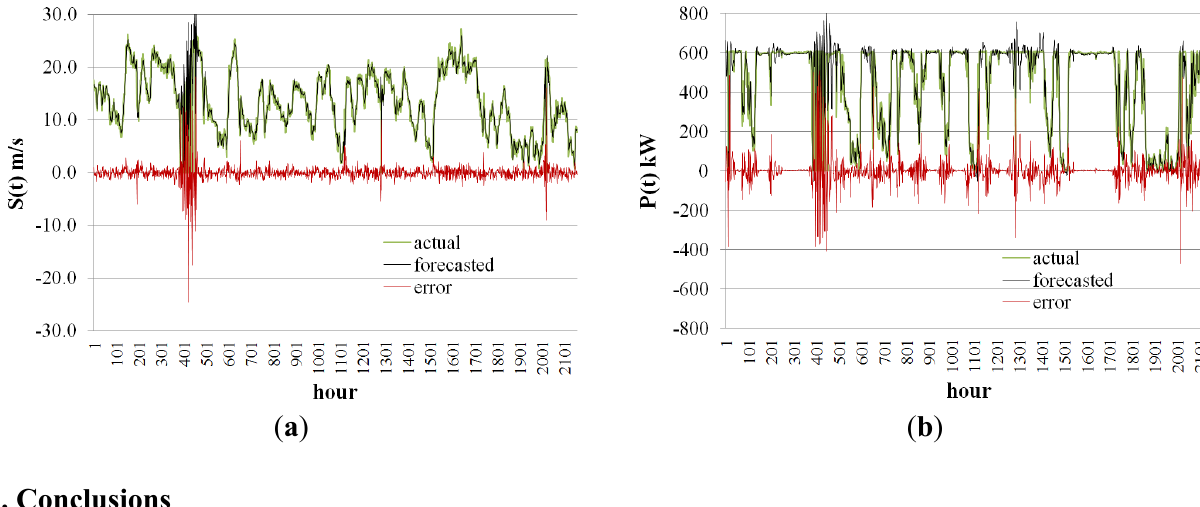
Figure 10. Actual/forecasted wind speeds/powers and errors during the winter: ( a ) S( t ); ( b ) P( t